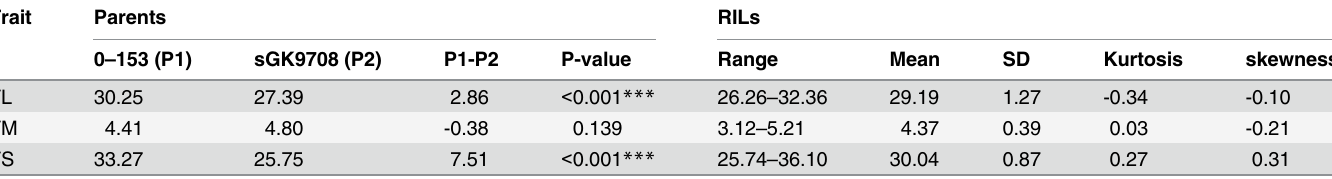
Table 1. Statistics of the mean phenotypic values of fiber length, fiber micronaire and fiber strength of RILs and their parents in 11 environments. Trait